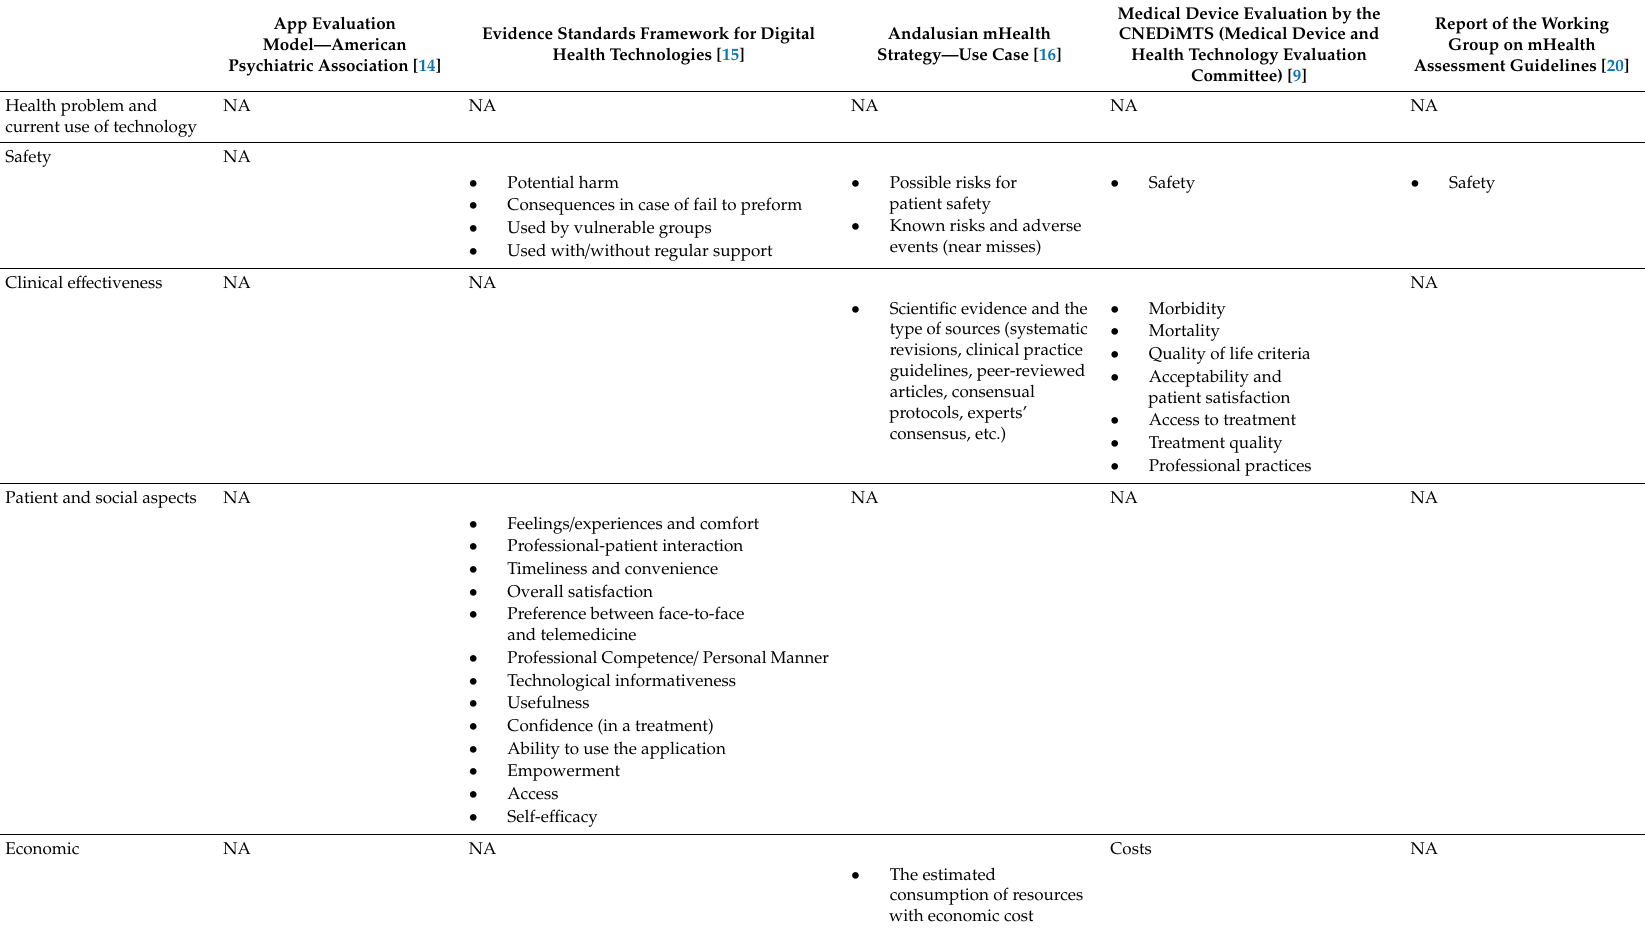
Table A4. Criteria